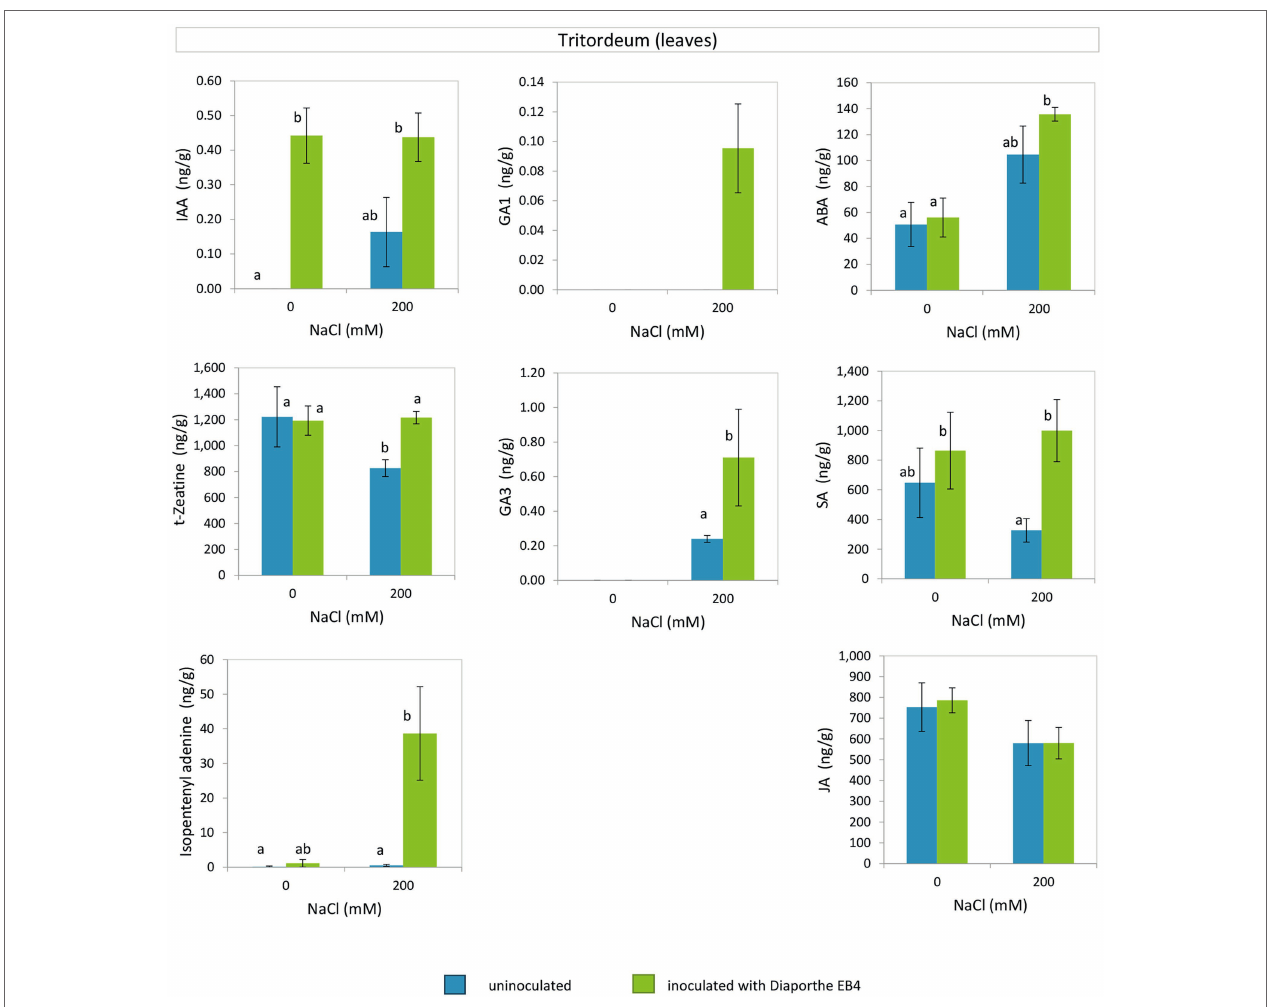
FIGURE 5 | Phytohormones in leaves of tritordeum plants not inoculated ( BLUE ) or inoculated with Diaporthe EB4 ( GREEN ), at two different salinity treatments (0 and 200 mM NaCl): indole acetic acid (IAA), cytokinins (t-zeatin and isopentenyladenine), gibberellins (GA1 and GA3), abscisic acid (ABA), salicylic acid (SA), and jasmonic acid (JA). Values are means ± SD ( n = 3). Different means are indicated with different letters (Tukey test p <